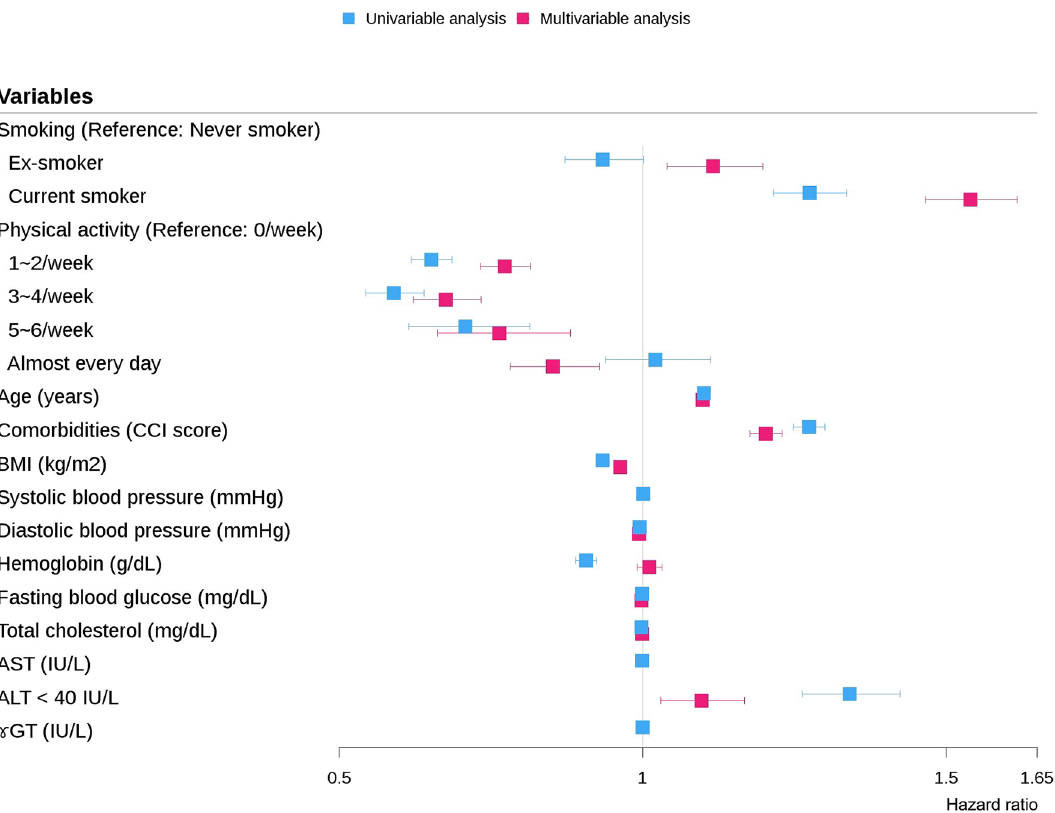
Figure 3. Hazard ratios for COPD development in males. AST aspartate aminotransferase, ALT alanine aminotransferase, BMI body mass index, CCI Charlson’s comorbidity index, COPD chronic obstructive pulmonary disease, ɤ GT gamma-glutamyl